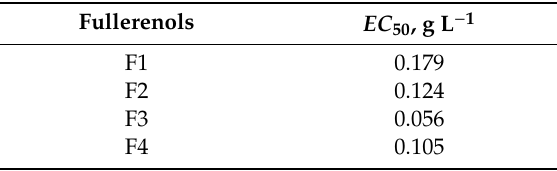
Table 5. Values of EC 50 of fullerenols in chemiluminescence assay.